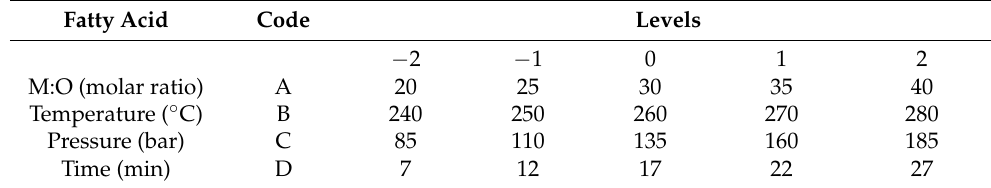
Table 3. Experimental design variables and their coded levels.